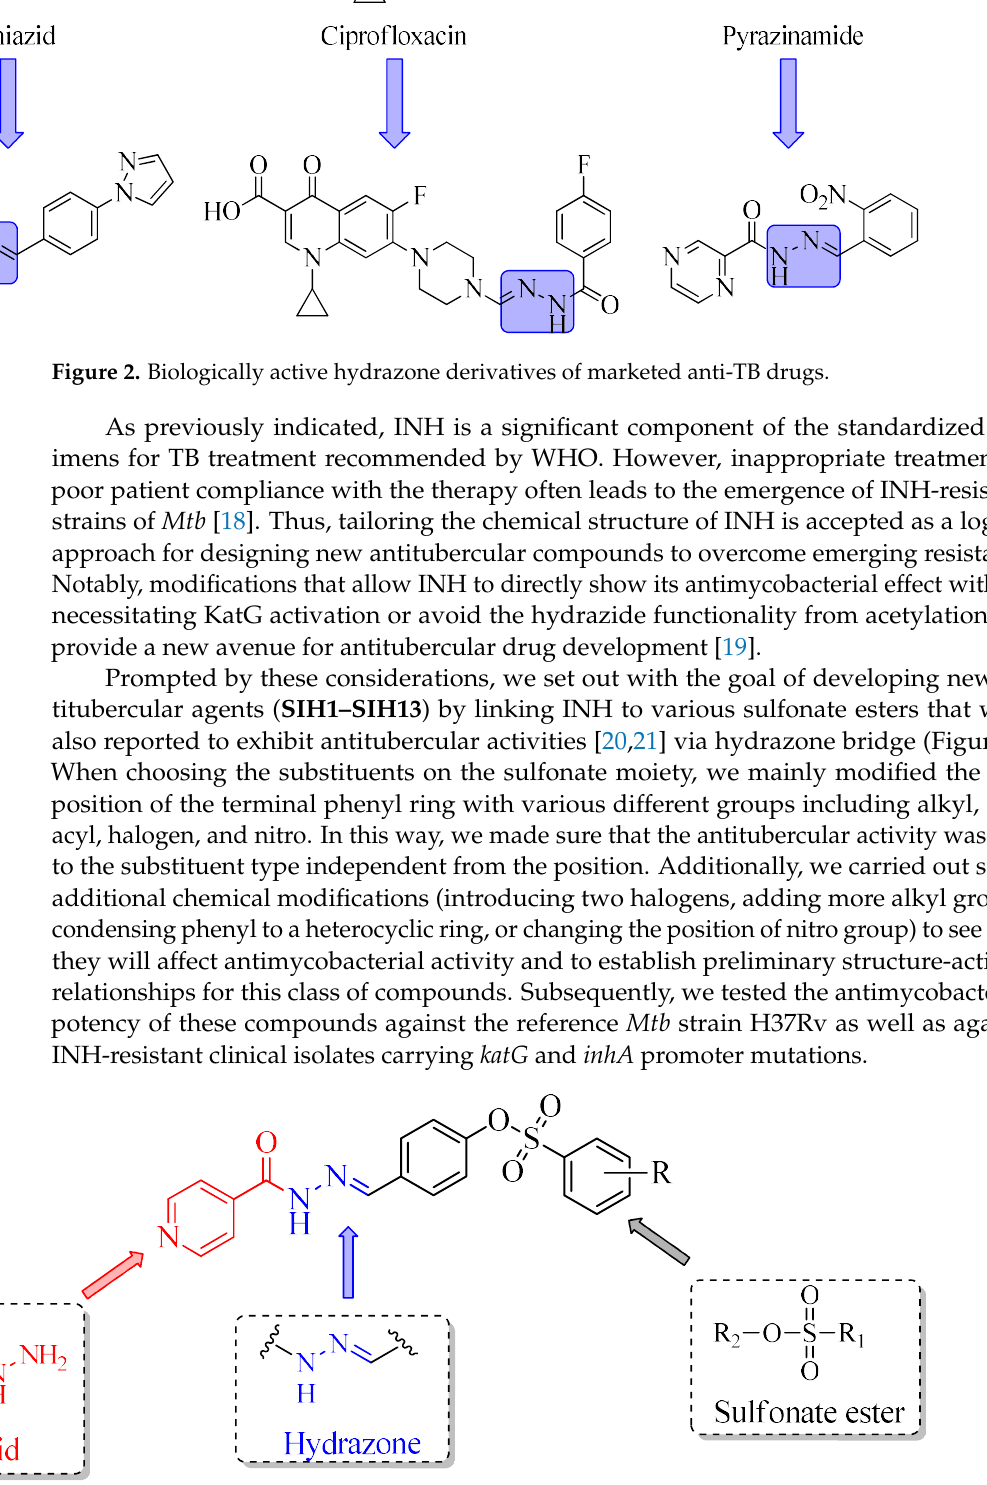
Figure 3. Design strategy of the studied molecules SIH1–SIH13 .